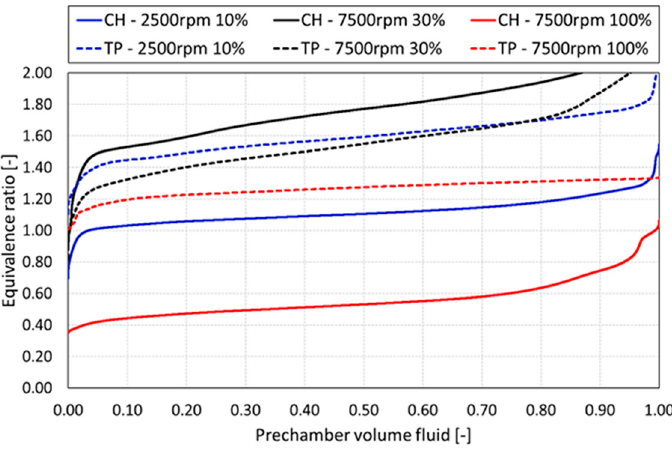
Figure 24. Fuel homogenization inside the PN8 prechamber at 360 °CA: comparison between CH injection (continuous lines) and TP injection (dashed lines).